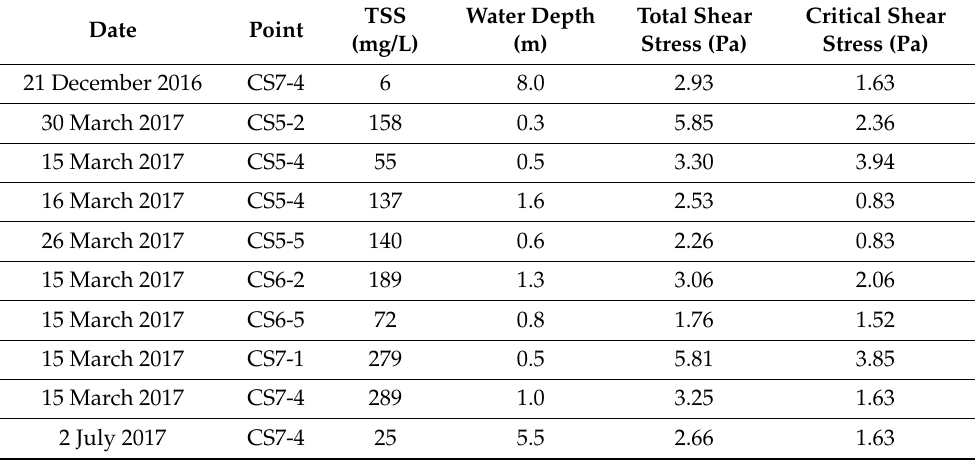
Table 5. Comparison of TSS, water depth, total shear stress, and critical shear stress across selected sites.